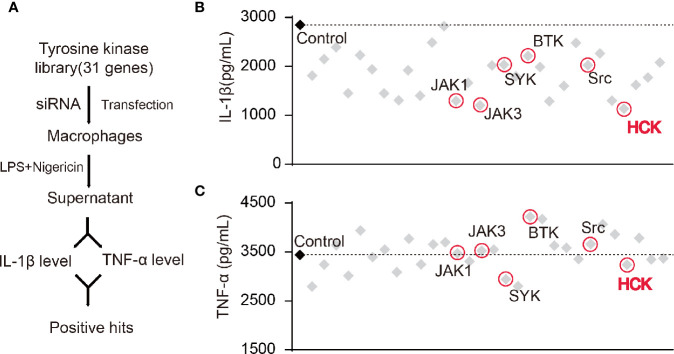
Screening of HCK as a regulator for the NLRP3 inflammasome. (A) Flowchart showing the candidate siRNA library targeting 31 putative tyrosine kinases in BMDM. IL-1β and TNF-α levels were determined. (B, C) Enzyme-linked immunosorbent assay (ELISA) for IL-1β
(B) or TNF-α (C) in supernatants from LPS-primed (500 ng, 3 h) PMs transfected with control siRNA (scrambled) or siRNAs specific for the individual tyrosine kinases post-nigericin (5 μM) stimulation for 30 min.